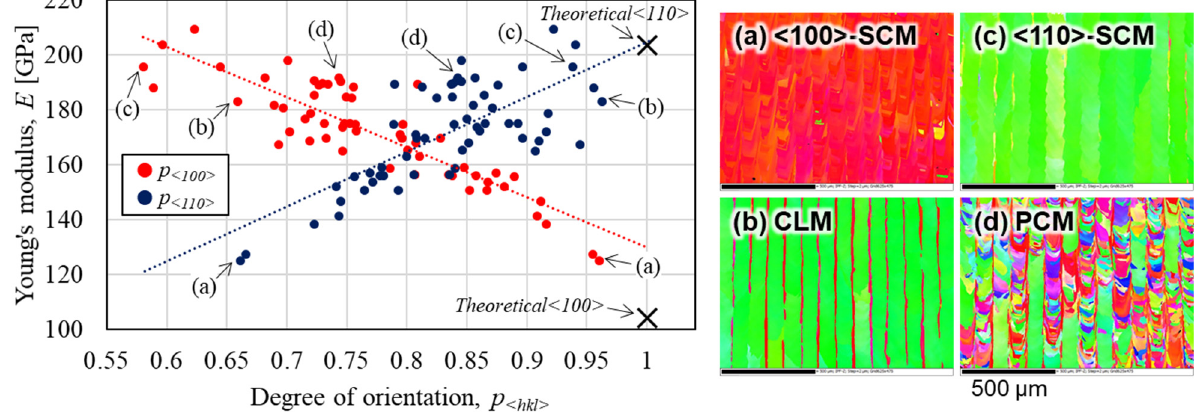
Figure 4. Relationships between the orientation parameter and Young’s modulus. The points indicated by the arrows (a–d) correspond to the IPF maps (a–d) on the right, respectively.